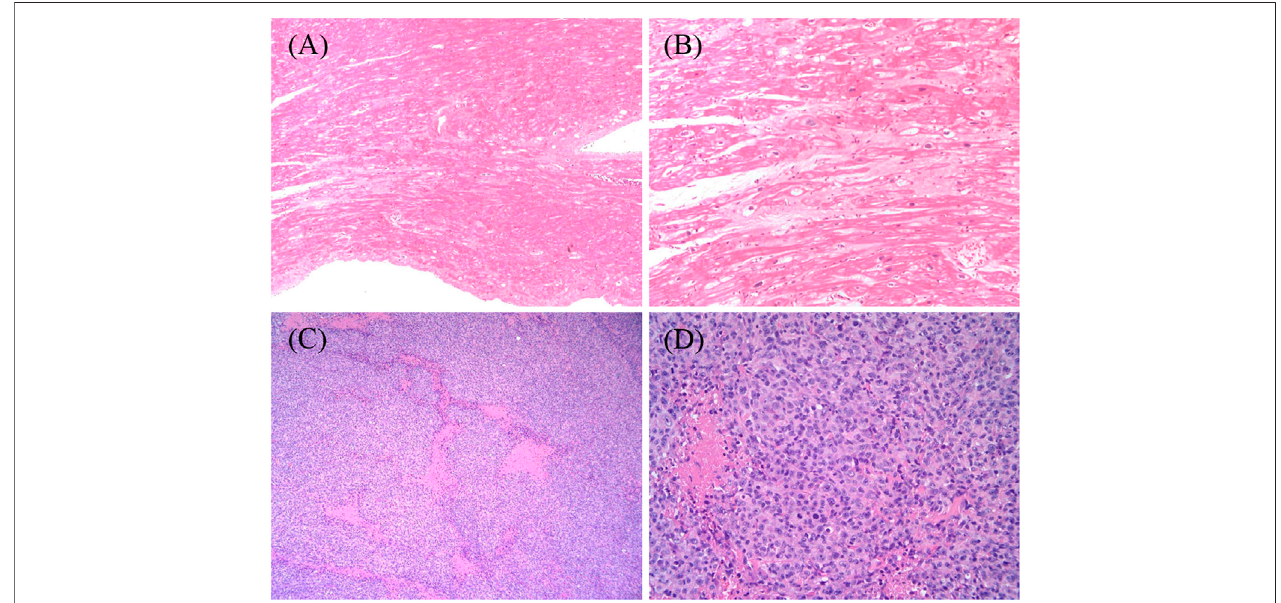
FIGURE 3 | (A,B) The structural changes of this transplant recipient ’ s myocardium, being magni fi ed respectively×100 and ×400 by light microscope. The myocardium of the specimen from the heart transplant recipient revealed hypertrophy of cardiomyocytes with disordered arrangement; segmental vacuolar degeneration; and myocardial fi bers blurring. (C,D) The histopathological characteristics of the biopsy tissue from retroauricular lymph nodes on the left side, being magni fi ed respectively×100 and ×400 by light microscope. The images show groups of lymphoma cells compartmentalized by fi ne fi brosis, large and arranged neoplasm in a diffuse pattern that partially effaces normal nodal architecture, and areas of geographic necrosis. The lymphoma cells are moderately large in size with an abundant amount of cytoplasm, most of which is without nucleoli.